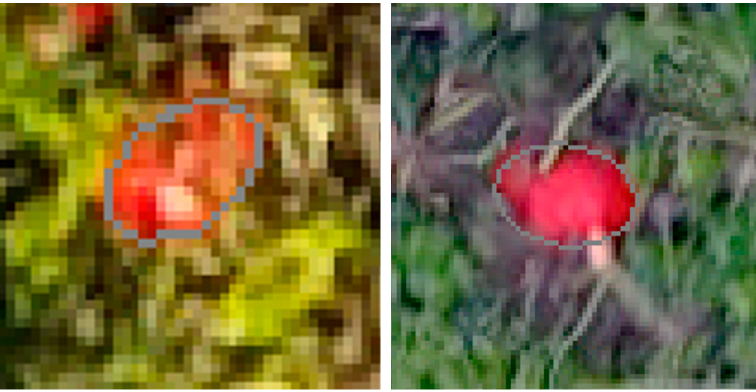
Figure 8. Prediction errors due to overlap by leaves ( left ) and insufficient image mosaicking ( right ).